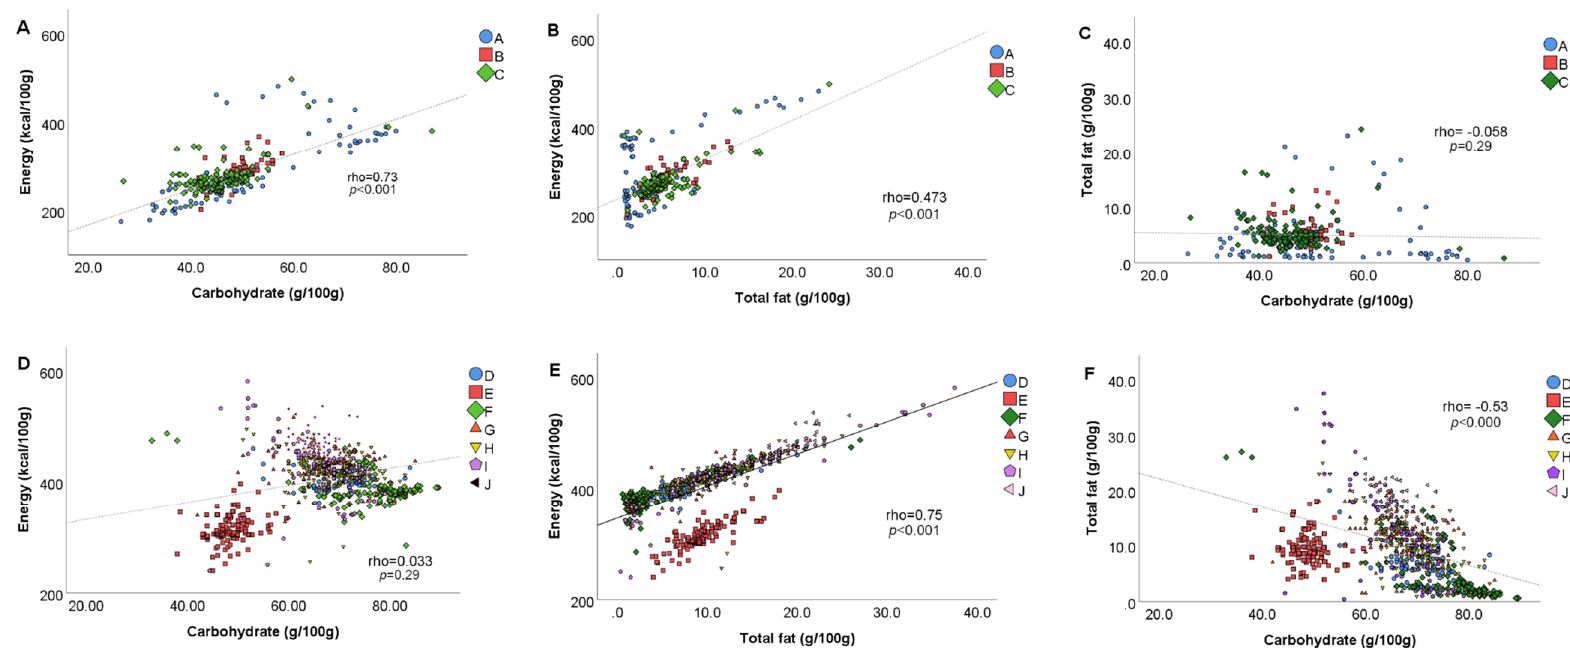
Figure 2. Bivariate correlations between energy (kcal / 100 g), total fat (g / 100 g) and carbohydrates (g / 100 g) contents of the analyzed bread and bread substitutes. Plots are relative to correlation between energy and carbohydrate contents in bread ( A ) and bread substitutes ( D ), energy and total fat contents in bread ( B ) and bread substitutes ( E ) and total fat and carbohydrate contents in bread ( C ) and bread substitute ( F ) items. Legend: A, loaf; B, rolls; C, sliced bread. D, crackers; E, wraps; F, breadsticks; G, rice and corn cakes; H, taralli; I, croutons, bruschetta and “Frisella” bread; J, rusks.